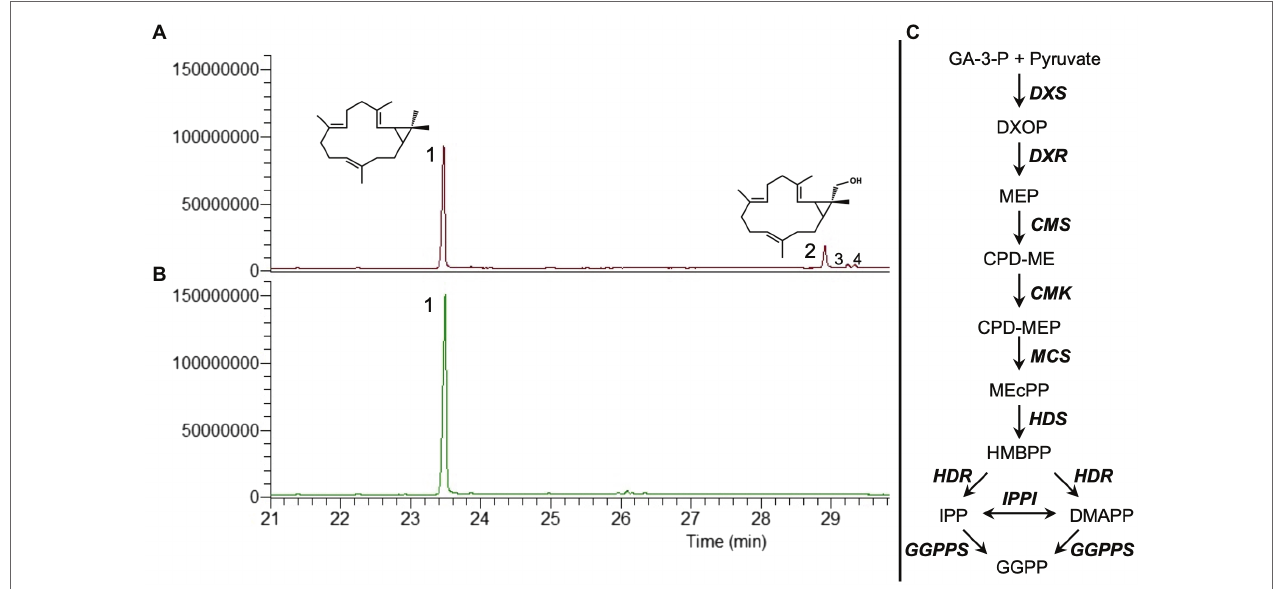
FIGURE 1 | GC–MS total ion chromatograms (TIC) showing the diterpene profile of N. benthamiana infiltrated with casbene synthase (CAS) and different precursor genes. (A) Co-expression of DXS + GGPPS + CAS . (B) Co-expression of DXS + HDR + GGPPS + CAS . (C) Simplified diagram of the MEP pathway plus geranylgeranyl pyrophosphate synthase (GGPPS). MEP pathway enzymes are DXS (1-deoxy-D-xylulose 5-phosphate synthase), DXR (1-deoxy-D-xylulose 5-phosphate reductoisomerase), MCT (2-C-methyl-D-erythritol 4-phosphate cytidylyltransferase), CMK (4-(cytidine 5’diphospho)-2-C-methyl-D-erythritol kinase), MDS (2-C-methyl-D-erythritol 2,4-cyclodiphosphate synthase), HDS (4-hydroxy-3-methylbut-2-enyl-diphosphate synthase), HDR (4-hydroxy-3-methylbut-2-enyl diphosphate reductase), and IPPI (isopentenyl diphosphate Δ -isomerase). 1, casbene; 2, 16-hydroxy-casbene; and 3 and 4, undetermined